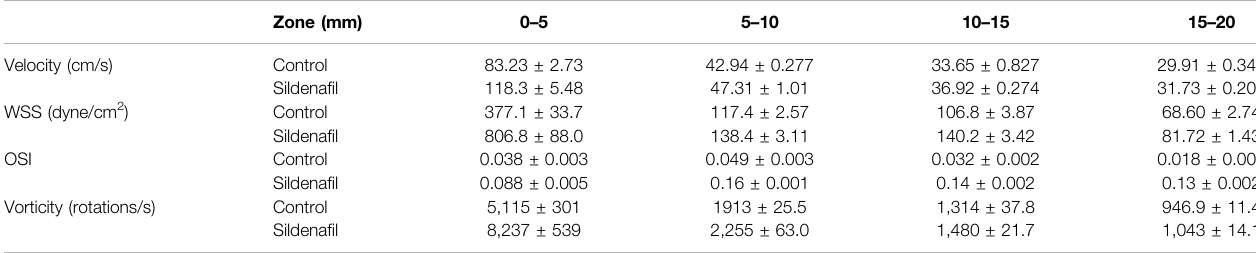
TABLE 2 | Hemodynamic parameter results by zone. Data reported as mean ±